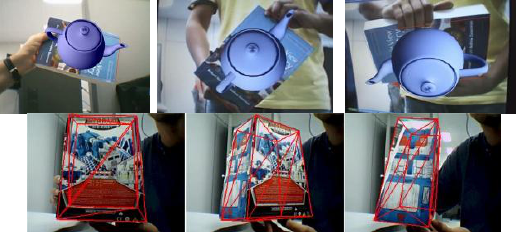
Figure 22. KB results using SIFT and LM with planar (top) and non-planar (bottom)